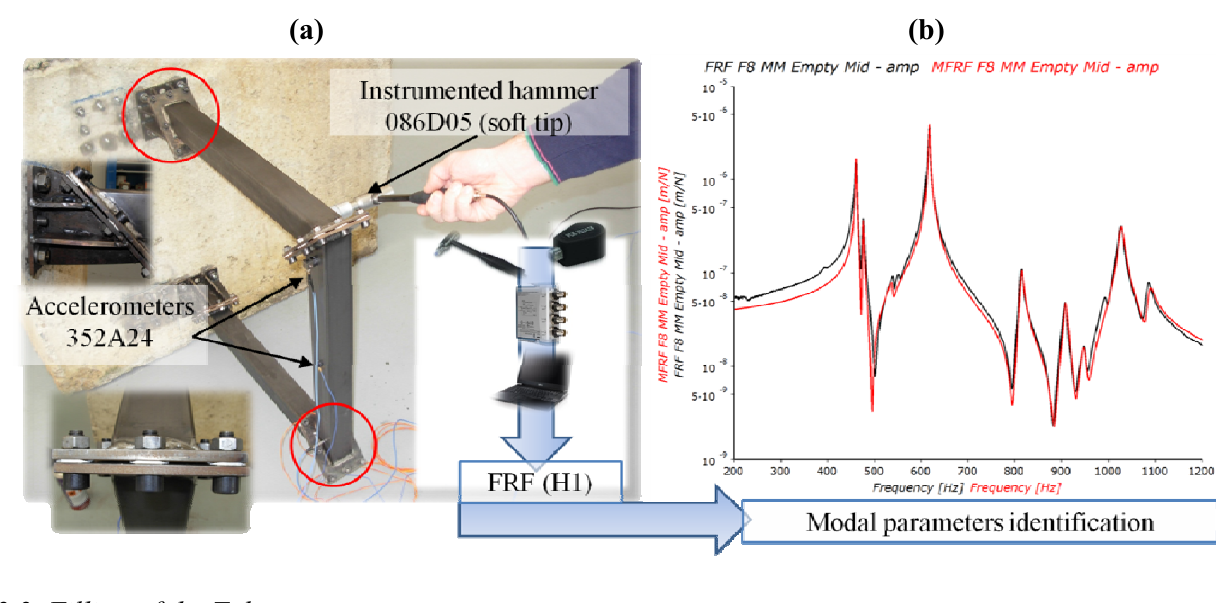
Figure 3. ( a ) Experimental setup for the frequency response functions (FRF) estimation along with accelerometer and impact point positions. Ground and internal constraints; ( b ) Example of a measured FRF in black (H1 estimator) and corresponding identified FRF in red, for mid-frequency